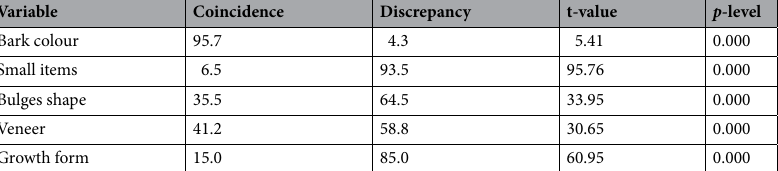
Table 3. Coincidence and discrepancy rates of the morphological traits and technical quality between parent clone and progeny plants. (t-value—student T-test of deviances of discrepancy rates from zero; Bark colour— dark or white; Small items—shrubs with any type of bulges and trees with ring or sphere shape of bulges; Bulges shape—ring, dense, shallow, or sphere; Veneer—tree growth form with the external presence of shallow and dense types of bulges; Growth form—tree or